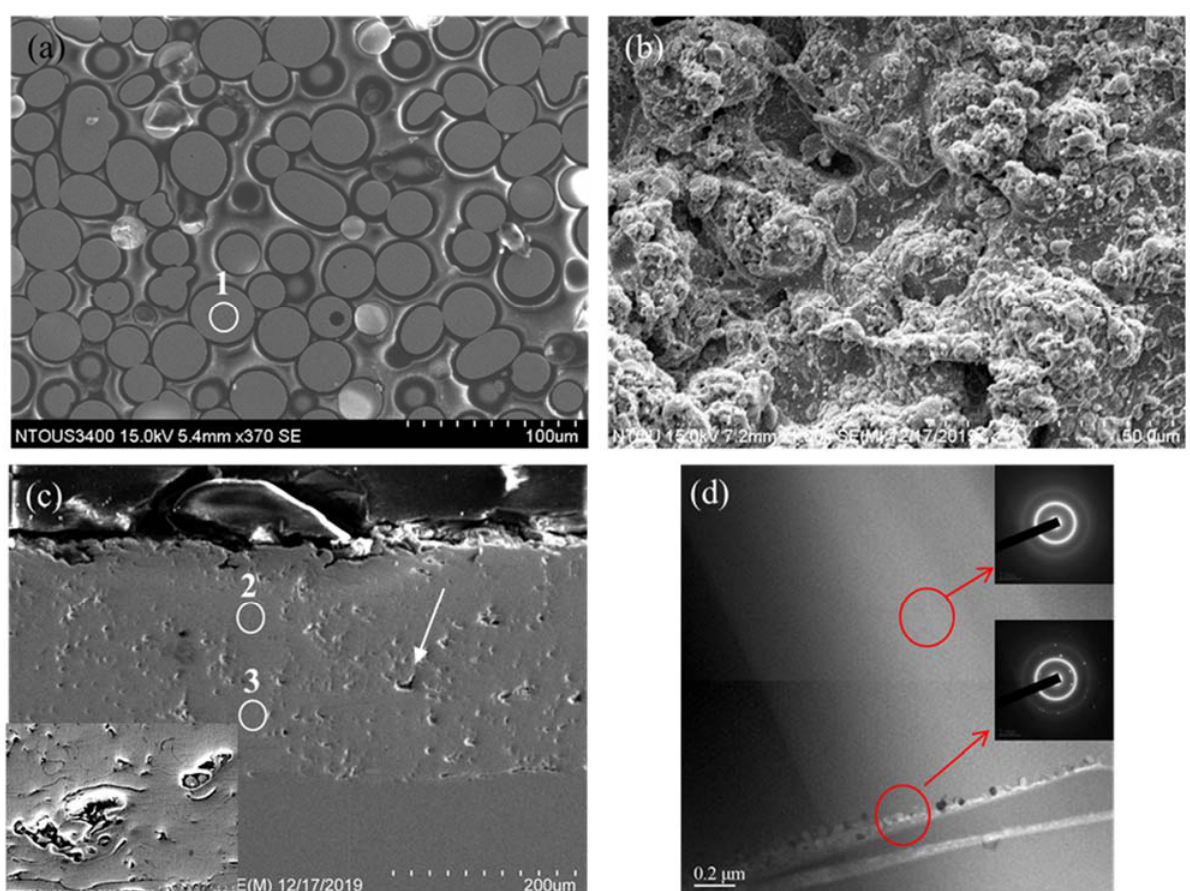
Figure 1. SEM images of Fe-based amorphous alloy coating before annealing: ( a ) initial powders, ( b ) surface of coating, ( c ) cross-section of coating, ( d ) TEM image of coating. Table 1. SEM-EDS chemical composition analysis of Fe-based amorphous alloy coating before annealing (the analyzed positions are indicated by the white circles in Figure 1a,c).